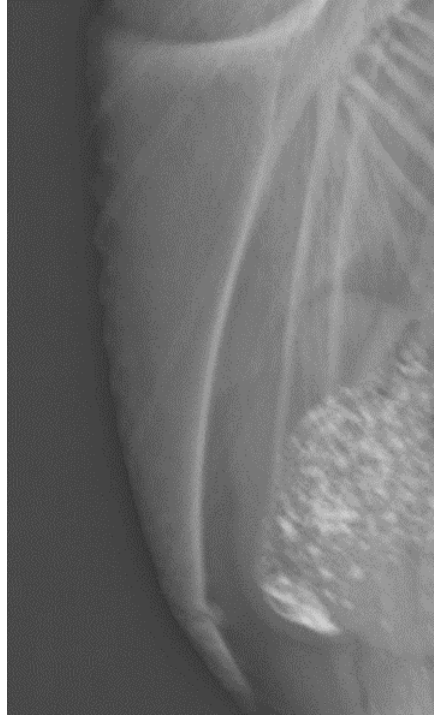
Figure 2 . A keel bone with one fracture, 30 weeks of age.